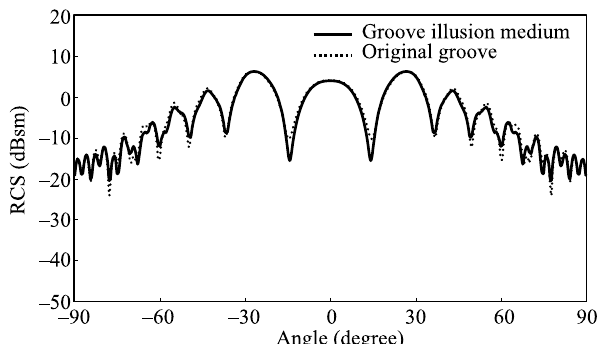
Fig. 10. Calculated RCSs for the groove illusion medium and the original groove.